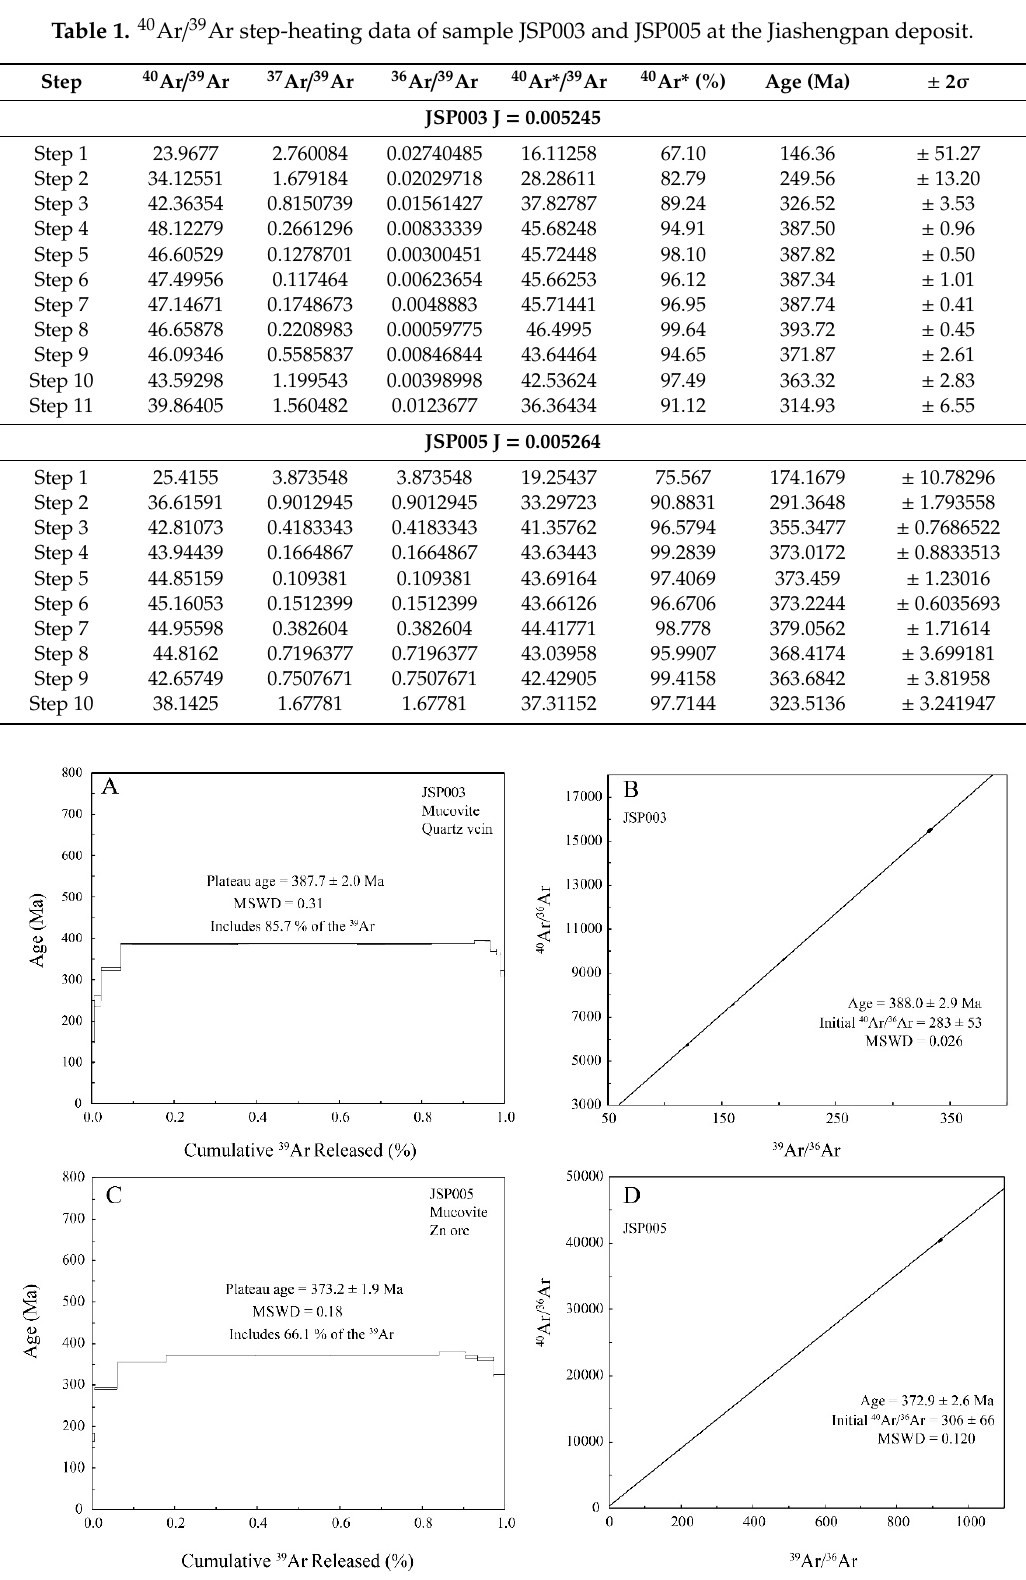
Figure 5. 40 Ar/ 39 Ar plateau and isochron ages of muscovite samples (JSP003 and 005) from the Jiashengpan deposit. ( A ) Plateau age of the muscovite separated from sample JSP003. ( B ) Isochron age of muscovite sample (JSP003). ( C ) Plateau age of the muscovite separated from sample JSP005. ( D ) Isochron age of muscovite sample (JSP005).